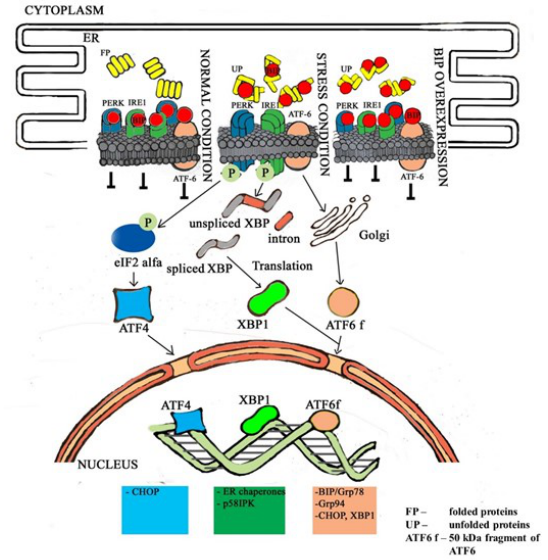
Figure 9. A schematic describing the altered response of R and T cells to tunicamycin-induced ER stress: In the absence of tunicamycin, all three ER stress receptors (PERK, IRE1, and ATF-6) are